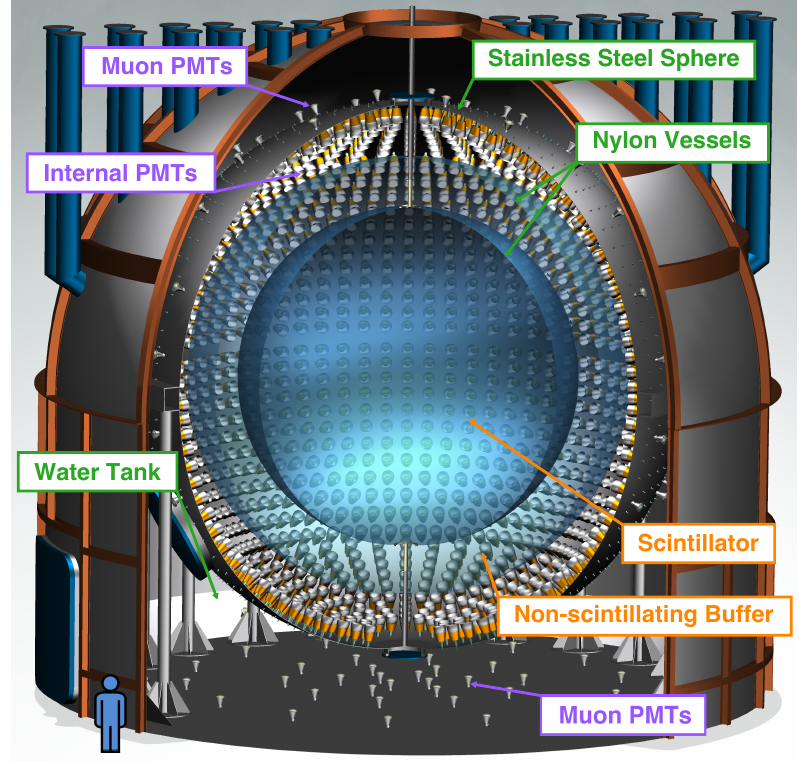
Figure 1. Schematic view of the Borexino detector. From inside to outside: the liquid scintillator contained in the nylon inner vessel, nylon outer vessel, stainless steel sphere, and the water tank for the Cherenkov muon veto. From